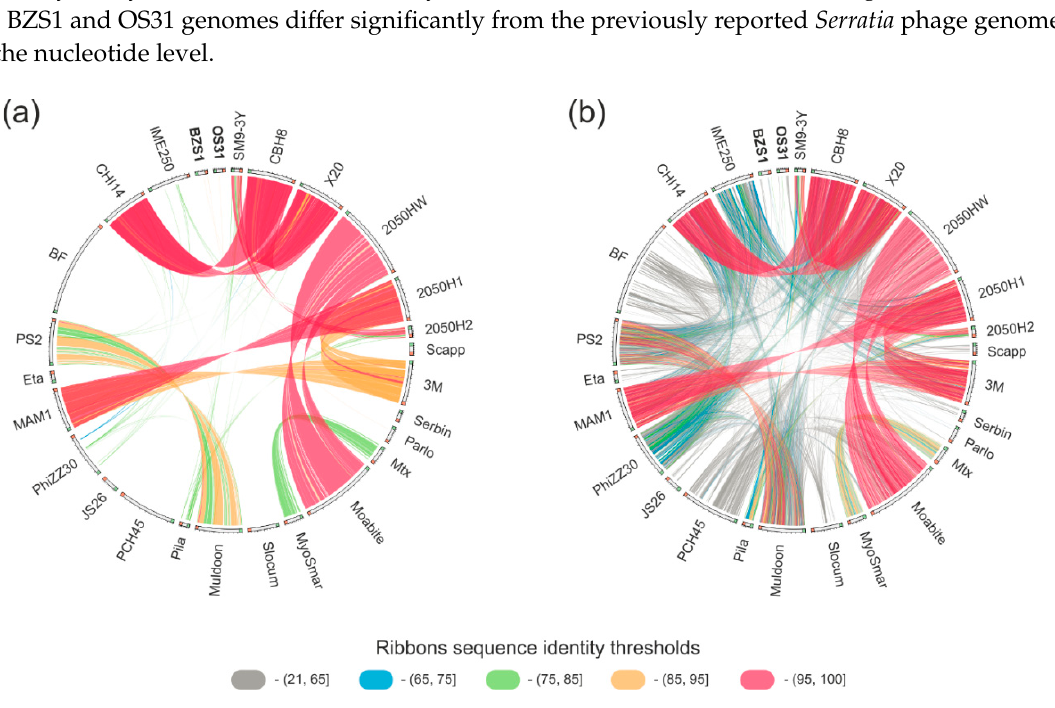
Figure 3. Comparison of BZS1 and OS31 with other Serratia phages. Similarities were based on nucleotide (a) and protein (b) all against all BLAST searches. Similarities are reflected by the ribbons connecting ideograms. Their colors reflect the scale of similarity between phage genome parts (a) or phage ‐ encoded proteins (b) , as indicated in the legend. The anchors of ribbons correspond to protein ‐ encoding genes location. Green and orange rectangles at the ends of ideograms reflect the beginning and end of phage genome.